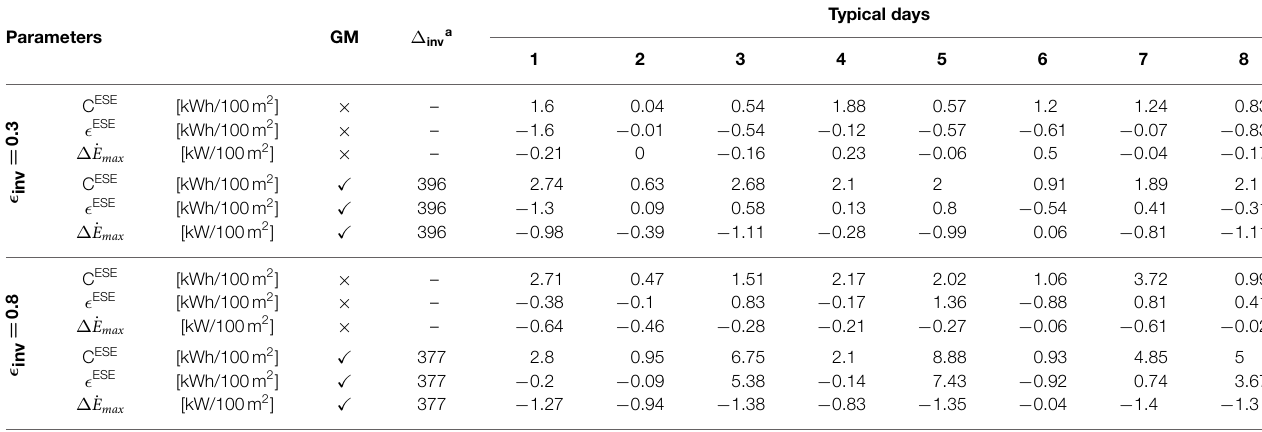
TABLE 2 | Comparison of building energy systems (BES) solutions with and without GM constraint for a single-family house (Geneva,